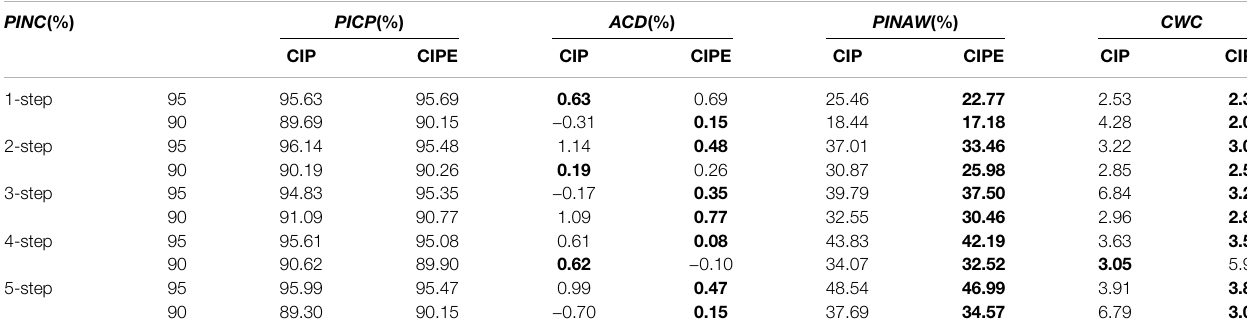
comparison of performance between CIPE and CIP under PINC = 90% in 2-step ahead prediction and under PINC =